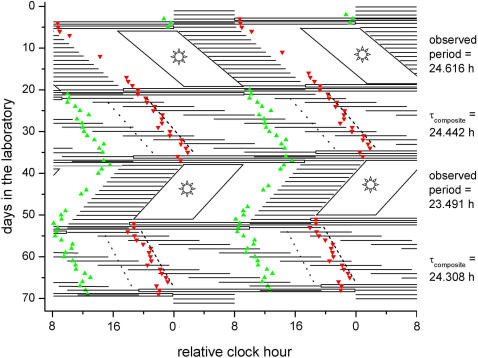
Raster plot of the study design for a representative individual (2478).The study protocol is double plotted such that consecutive days are next to and beneath the other. Scheduled sleep episodes in complete darkness (horizontal black lines), exposure to moderately bright light (parallelogram boxes with sun; part of wake episodes Days 6–19, 38–51), and CP procedures (open horizontal boxes; on Days 4–5, 20–21, 36–37, 52–53, 68–69) are indicated. Except for the scheduled wake episodes during the baseline (Day 1–3) and recovery days (Day 70–73; ∼90 lux [∼0.23 W/m2]) and exposure to moderately bright light (∼450 lux [∼1.18 W/m2]), lights were dim throughout the study (∼1.8 lux [∼0.0048 W/m2]). DLMOn25% (green upward-triangles) and DLMOff25% (red downward-triangles) are shown during dim light conditions. The intrinsic circadian period of the melatonin, cortisol, and temperature cycles during the FD protocols (Days 22–35, 54–67) were computed by a nonorthogonal spectral analysis technique. The fitted phase of the minimum of core body temperature (gray dotted line) and of the maximum of plasma cortisol (black dashed line) during the FD protocols are indicated. The observed circadian periods during the exposure to the 24.65-h day and to the 23.5-h day and the composite estimate of the intrinsic circadian period as computed by averaging the intrinsic period estimate from plasma melatonin, plasma cortisol, and core body temperature data (τcomposite) [13] for both FD protocols are indicated to the right of the figure.